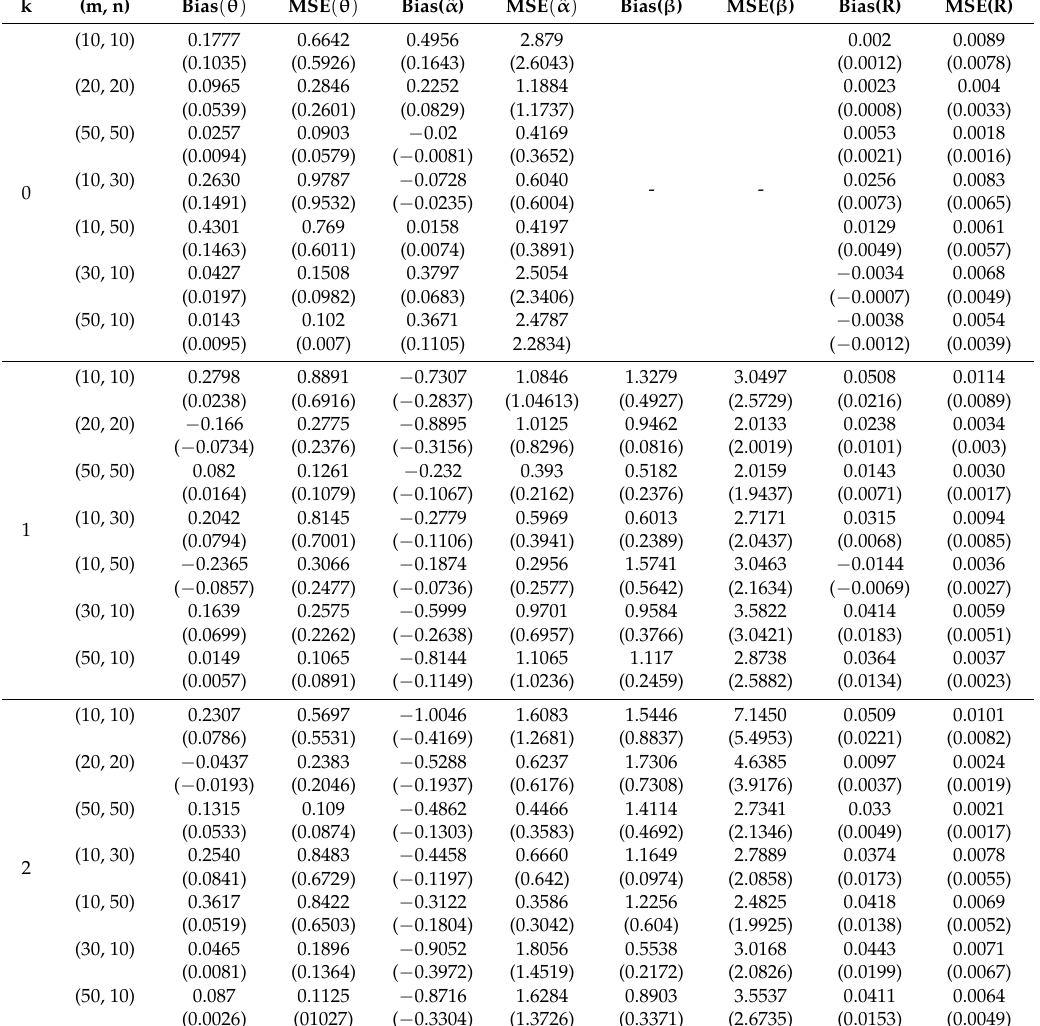
Table 1. Average Bias and mean square errors (MSEs) for ( ˆ θ , ˆ α , ˆ β , ˆR ) ( λ is known, λ = 2, α = 7, β = 5, θ = 4).